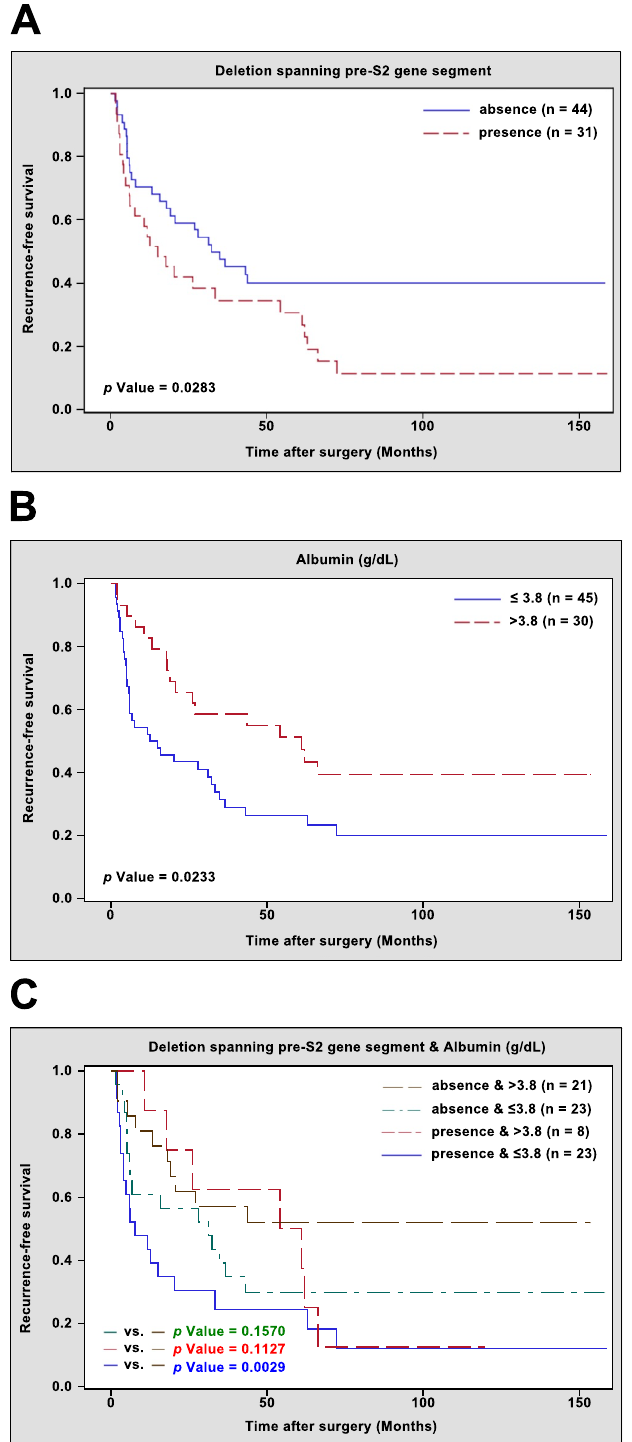
Figure 1. Kaplan–Meier curves for comparing the RFS difference between different groups of HBV- related HCC patients after curative surgical resection. ( A ) RFS difference between patients with the presence and absence of deletion spanning the pre-S2 gene segment. ( B ) RFS difference between patients with high (>3.8 g/dL) and low ( ≤ 3.8 g/dL) serum albumin level. ( C ) RFS difference between patients with the presence or absence of deletion spanning the pre-S2 gene segment in combination with high or low serum albumin level. Statistical significance of RFS difference shown in the lower left